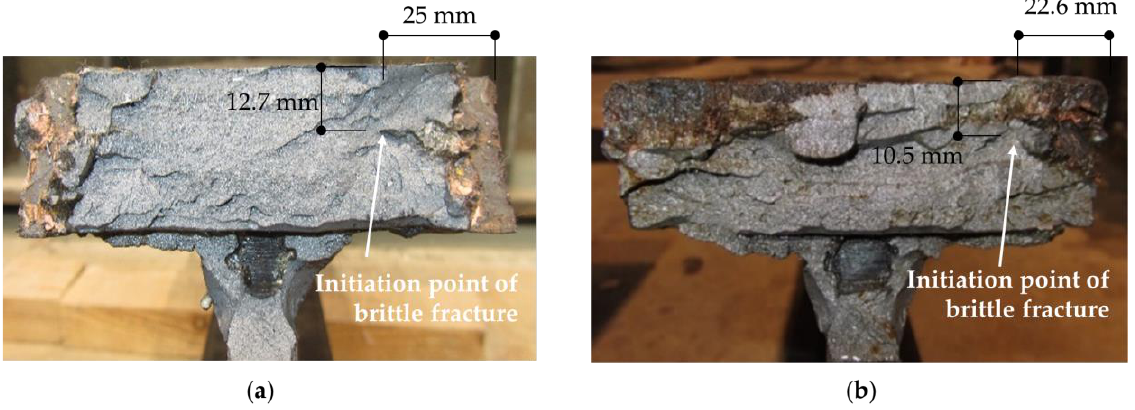
Figure 7. Fracture surfaces of the ( a ) FTC-8C and ( b ) FSC-14C specimens. Figure 8 shows the hysteresis loops obtained from the experiments.